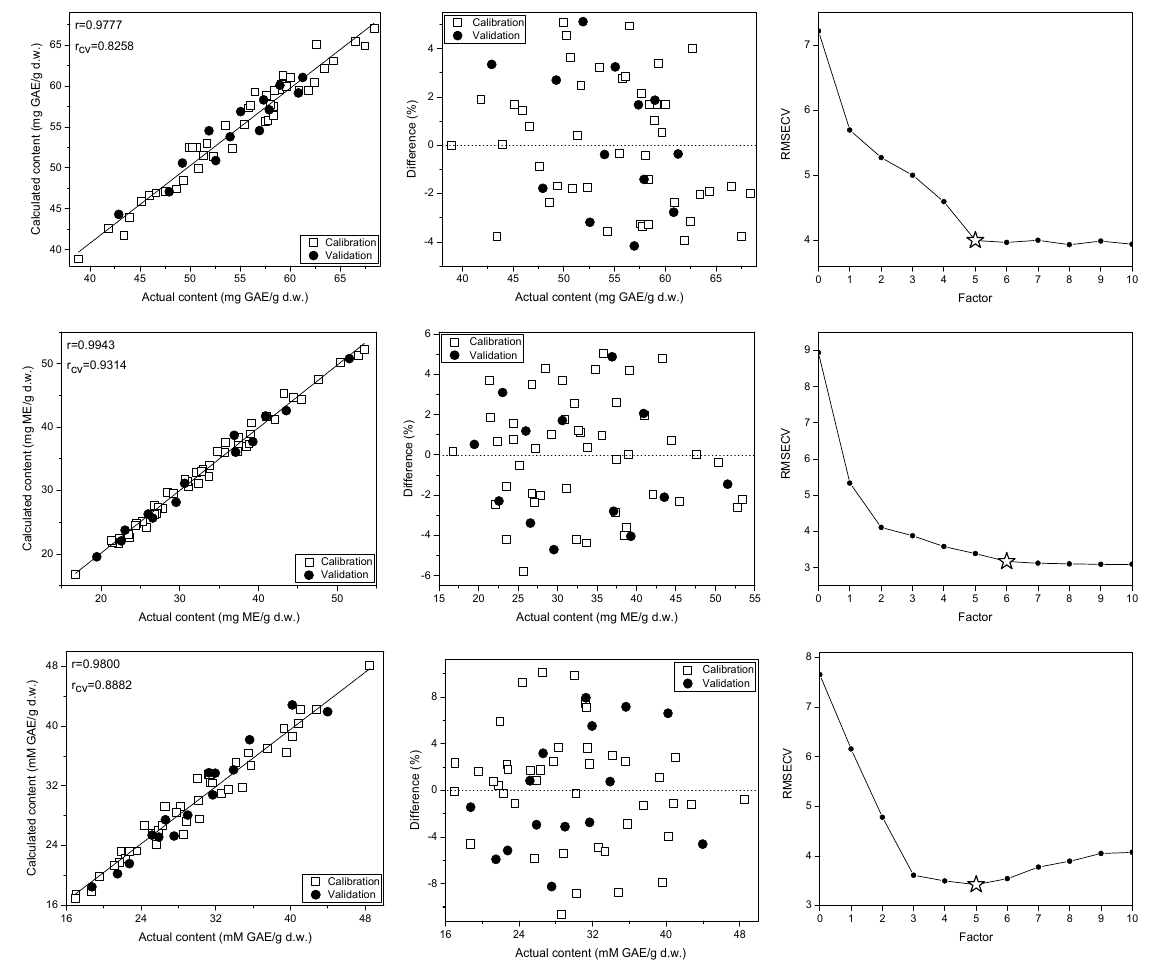
Figure 5. Prediction curves, relative errors and RMSECV plots for the TPC ( top ), TF ( middle ) and FRAP antioxidant activity ( bottom )determination in the C. incanus material on the basis of Raman spectra .